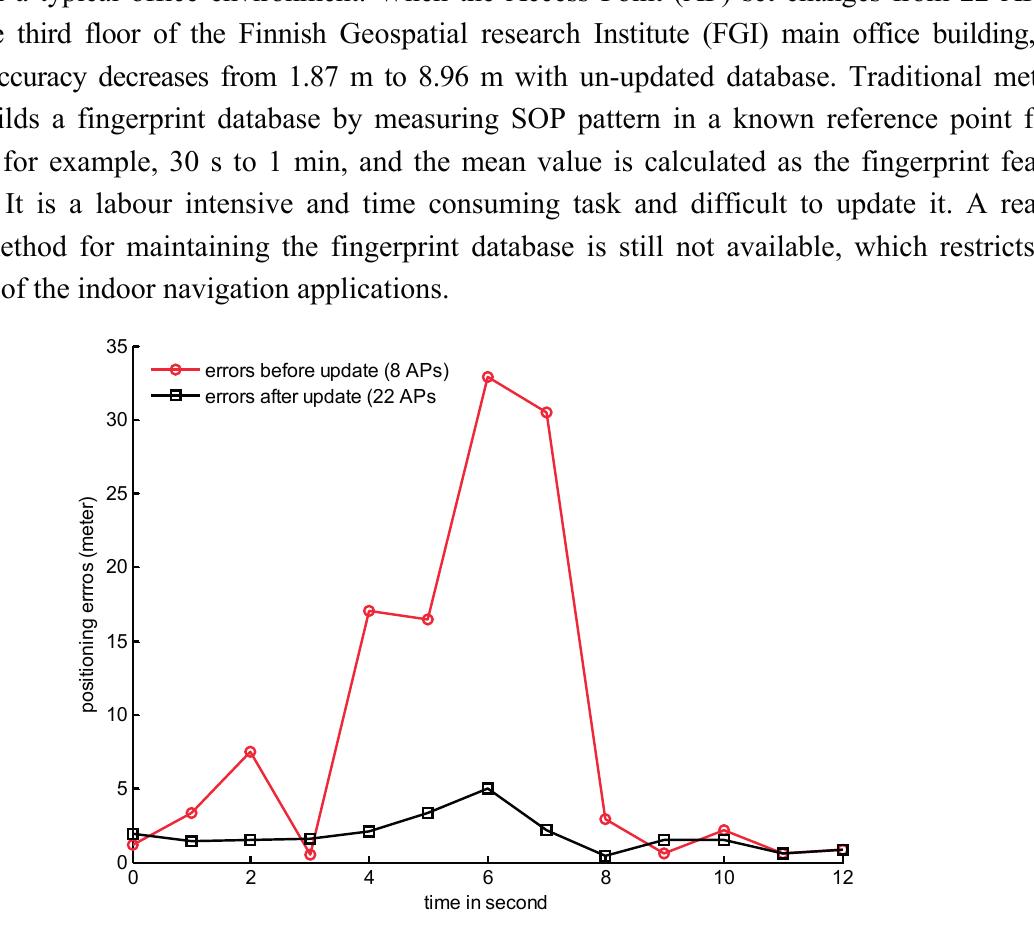
Figure 1. Comparison of positioning errors before/after the updated set of access